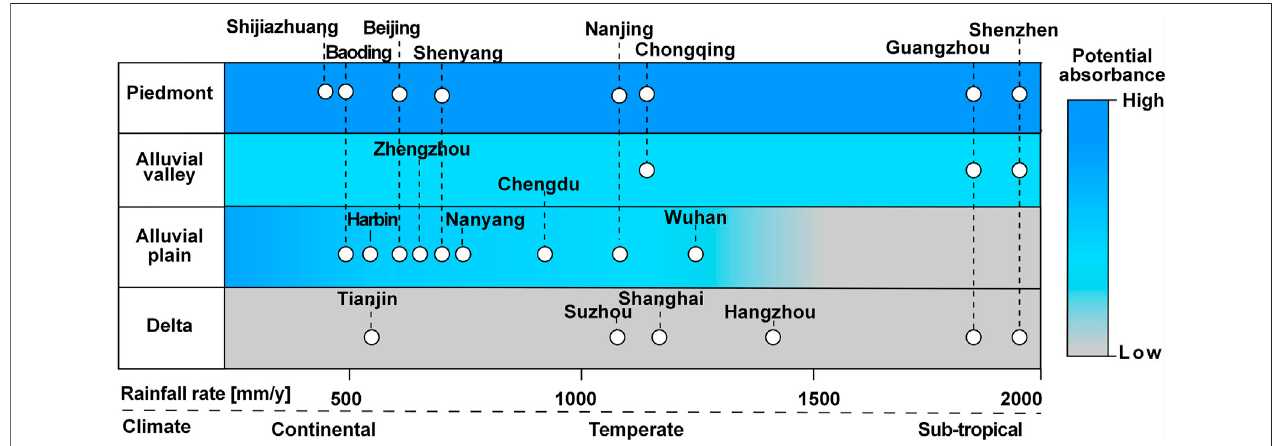
FIGURE 7 | Subsoil characteristics and rainfall rate de fi ne the absorbance potential at the regional scale. Alluvial valleys fractured to karst bedrock and piedmont have a good potential absorbance at any rainfall rate. The recent exploitation of urban aquifers has increased absorbance potential on the alluvial plains and in the Sichuan Basin at Chengdu. A low potential absorbance characterizes the delta areas in all climatic